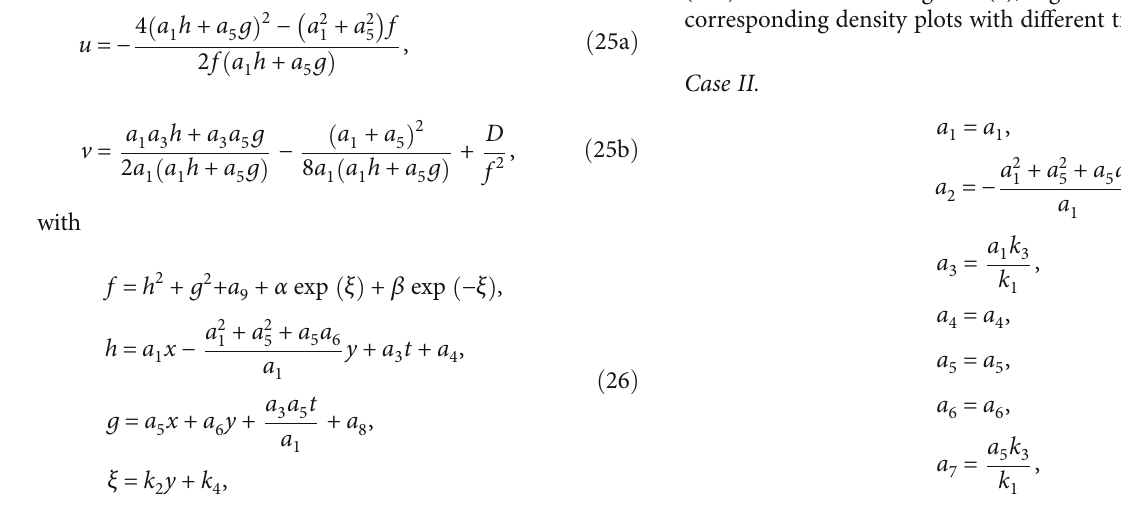
Figure 3: Pro fi les of the solution u via (30a) with a 3-dimensional plot with the time t = 0 ; (b – d) the corresponding density plots with di ff erent